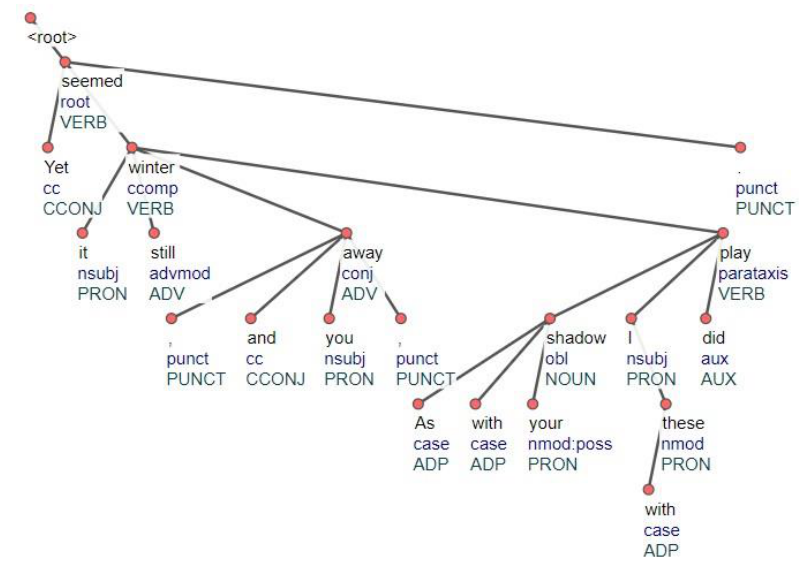
Figure 2. The syntax tree for a sentence from Shakespeare ’ s Sonnet 98.